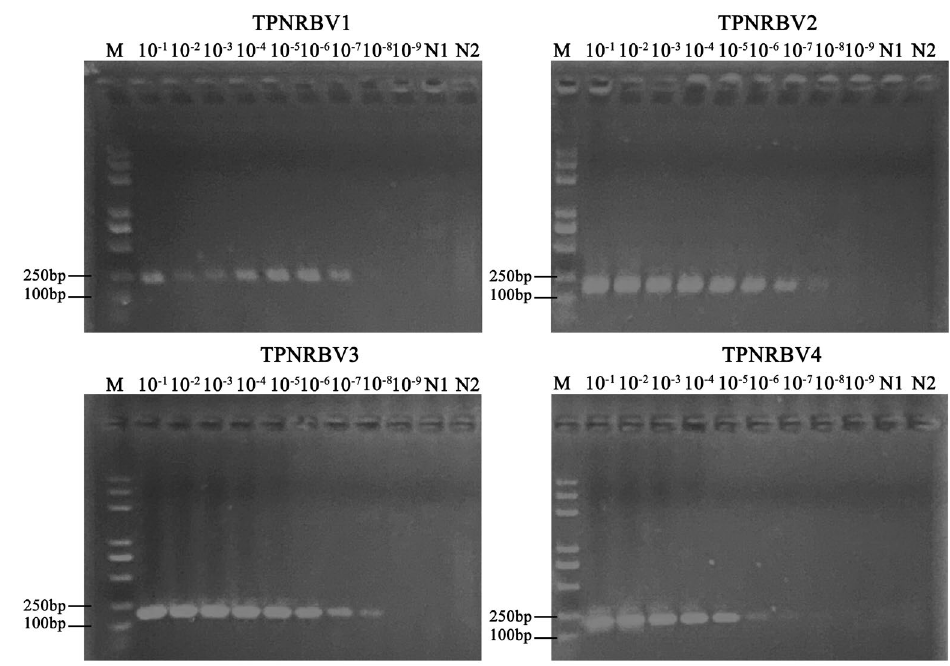
Figure 3. Detection of different concentrations of TPNRBV plasmid using PCR. M —Marker; Lanes 2–9 —10-fold serial dilutions of plasmids; N1 —Negative control using cDNA from TPNRBV-free sample as template; N2 —Negative control using water as template.